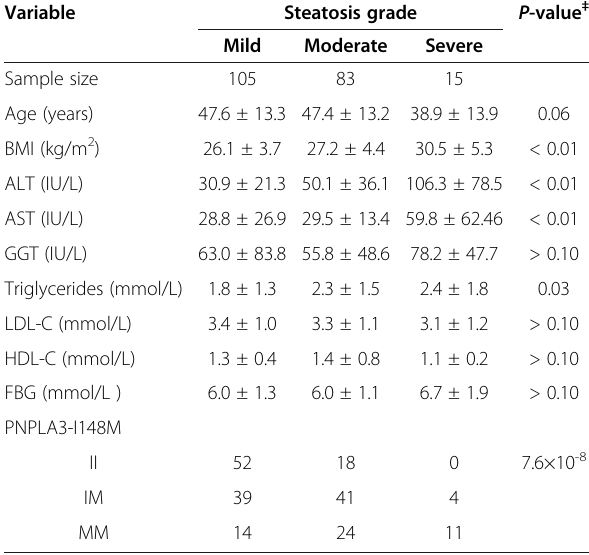
Table 1 Demographic, clinical, and genetic characteristics of NAFLD cases stratified by the ultrasonography- determined steatosis degree